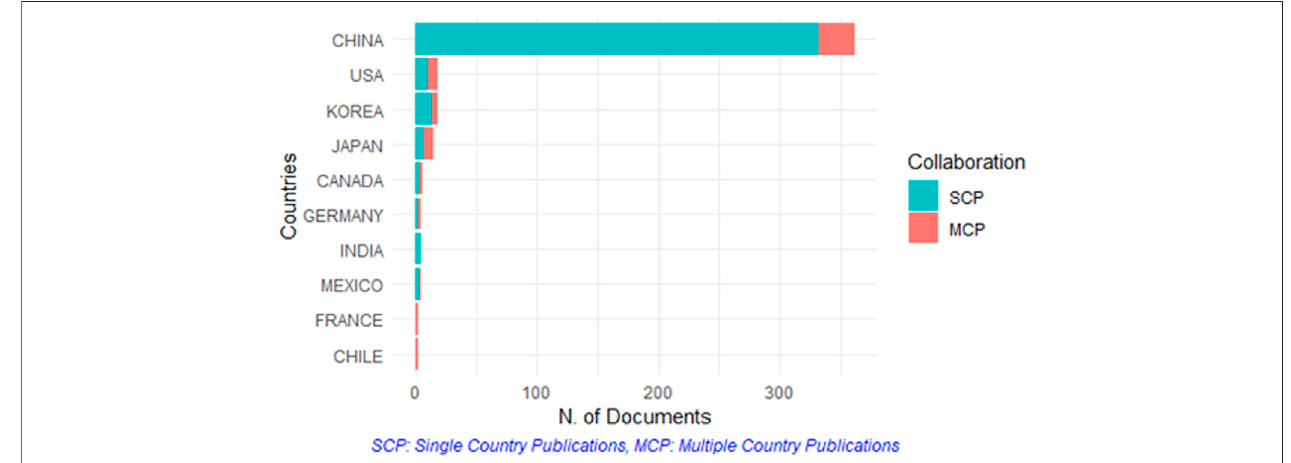
FIGURE 4 | Publication distributed by single country publications and multiple country publications.